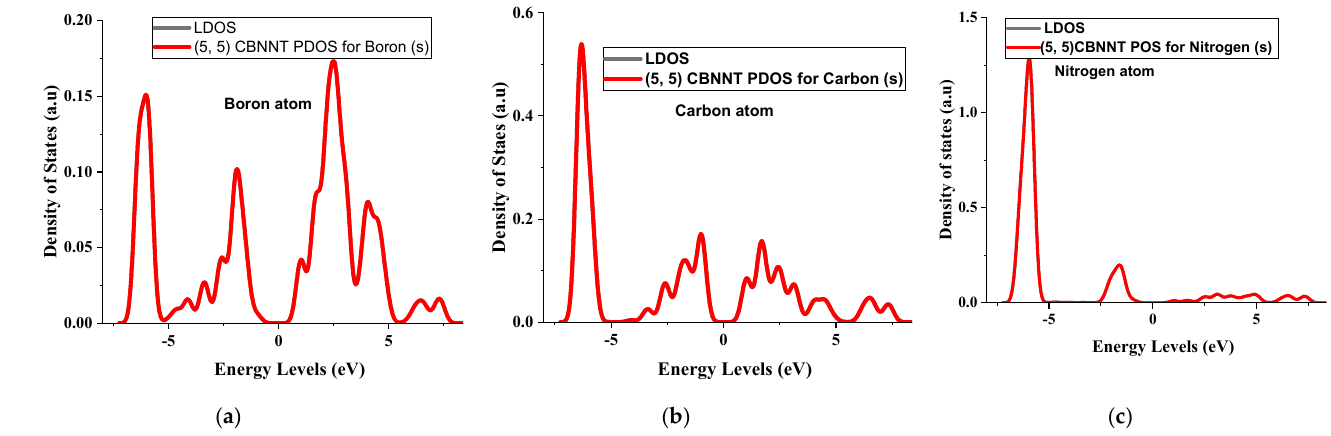
Figure 5. S orbital contribution to electrical properties of (5, 5) CBNNT system. ( a ) Boron atom ( b ) carbon atom ( c ) Nitrogen atom.